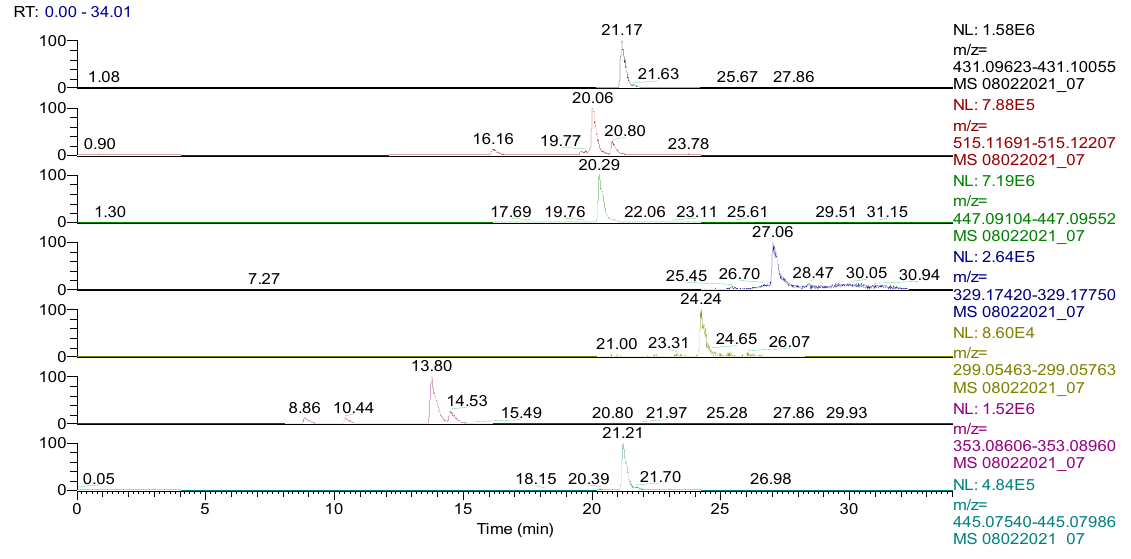
Figure 1. UHPLC–HRMS/MS chromatogram for CE in which were identified (top to bottom): vitexin ( m/z : 431.09839, Rt: 21.17), 1,5-dicaffeoylquinic acid ( m/z : 515.11949, Rt: 20.06), kaempherol (luteolin)-O-glucoside ( m/z : 447.09331, Rt: 20.29), carnosol ( m/z : 329.17585, Rt: 27.06), hispidulin ( m/z : 299.05613, Rt: 24.24), chlorogenic/neochlorogenic acid ( m/z : 353.08783, Rt: 10.44/13.80), and apigenin-7-O-glucuronide ( m/z : 445.07763, Rt: 21.21). According to our results, rutoside was identified in all extracts except AE; apigenin and kaempferol in all types of extracts; chlorogenic acid and caffeic acid in all extracts except CHE (where only chlorogenic acid was identified with one of its isomers); vitexin was identified in CE, TE, CHE, and AE; cynarine, scolimoside, and cynaropicrin were identified in CE; cichorin in CE, RE, and CHE; cynaroside and cynarotrioside in TE, CHE, and AE; catechin and epicatechin in CHE and AE; azelaic acid in all extracts; biochanin A in RE, CHE, and AE; genistin and daidzin in CHE; genistin in TE and AE; and condensed procyanidins (proanthocyanidins) in TE, CHE, and AE.